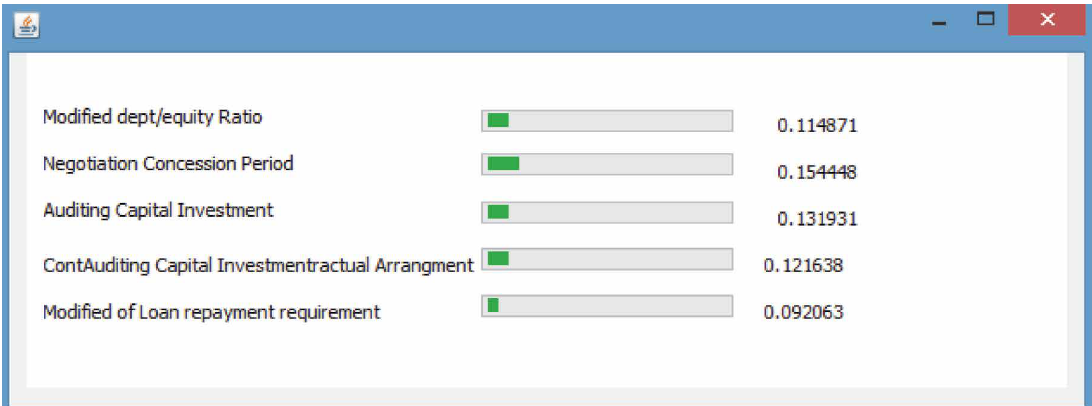
Figure 6. Local priorities of alternatives by the RAA3P